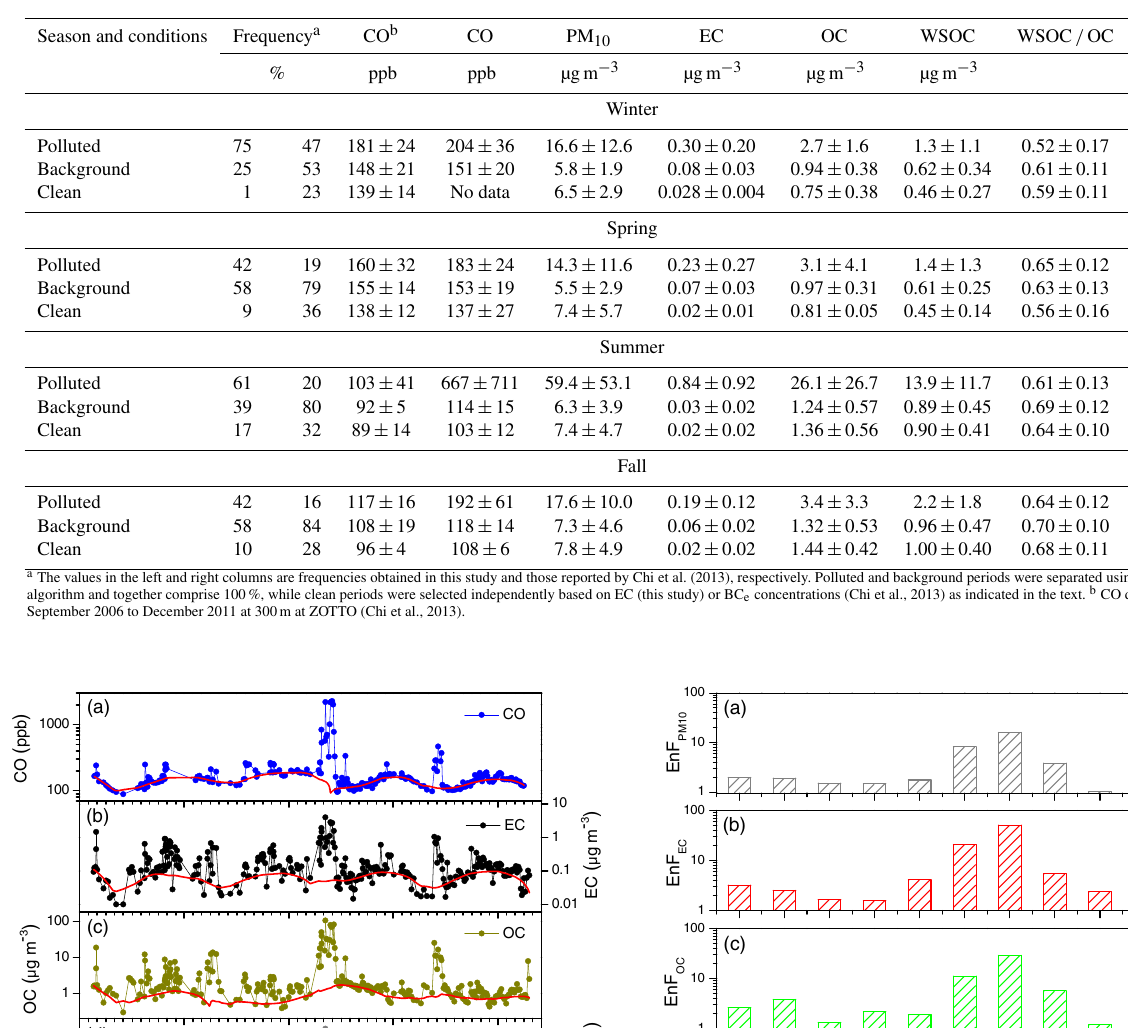
Table 2. Seasonal concentration ( ± SD) of CO, PM 10 , and carbonaceous species together with ratios and frequency representative of polluted, background, and clean periods obtained at ZOTTO from April 2010 to June 2014.